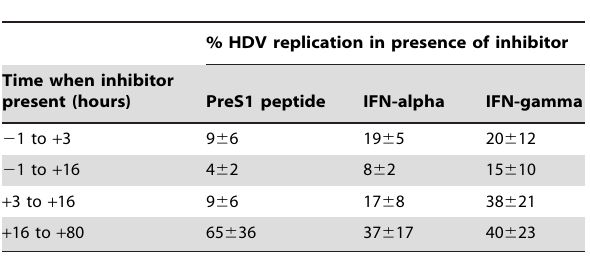
Table 1. HDV replication is inhibited by application of interferons alpha or gamma.